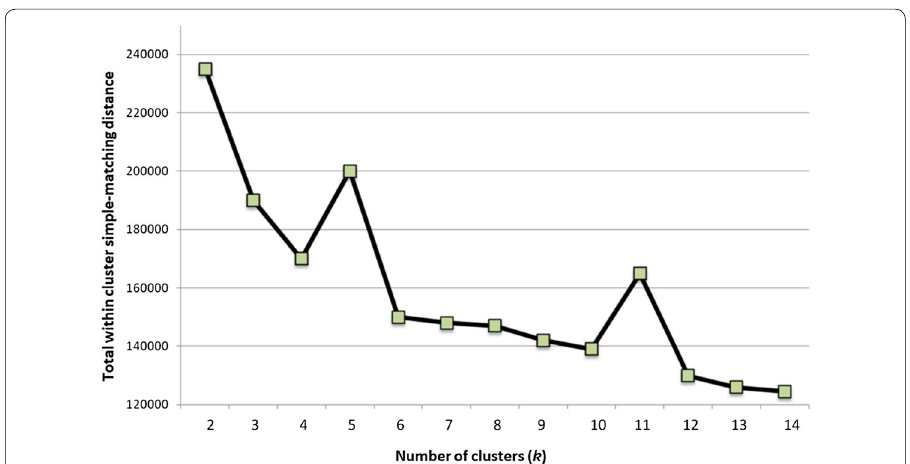
Fig. 15 Diagram for choosing the number of clusters (k